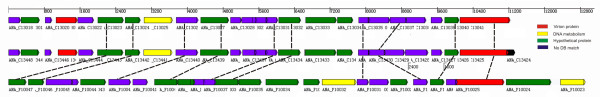
Organization of genes in the regions of the three putative prophage remnants. The remnants of the three putative prophages were found in the presence of the phage genes and highly compact organization. Two of the putative prophage remnants (~11 kb) on chromosome I share high sequence similarity (93.5%) and are located 500 kb apart. The third region of the prophage remnants (~13 kb) was located in plasmid A. Genes identified with BLASTp as having similarity to known phage genes are marked in red, DNA metabolism genes in yellow, hypothetical genes in green, and the novel genes without database counterpart in purple. The homologue genes shared among the three prophages were indicated by broken lines